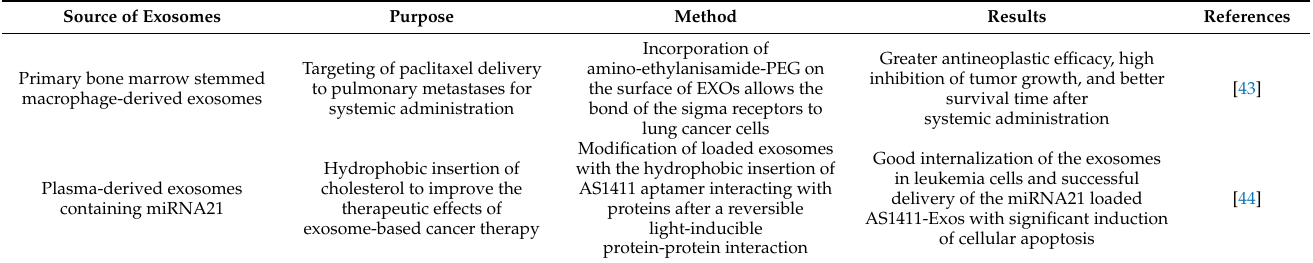
Table 5. Description of the studies dealing with chemical modifications on extracellular vesicle- mediated delivery cargo using hydrophobic insertion